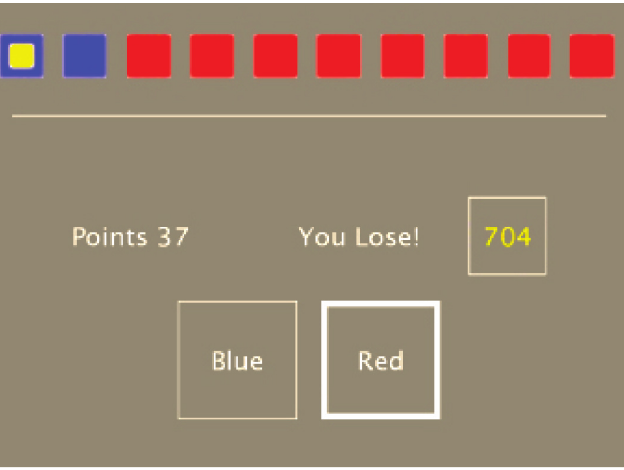
Fig 1. Screenshot from the Cambridge Gambling Task. Screenshot from the CGT. In this example, the subject bet on red, but the blue won. He/She lost 37 points ending up with 704 points.